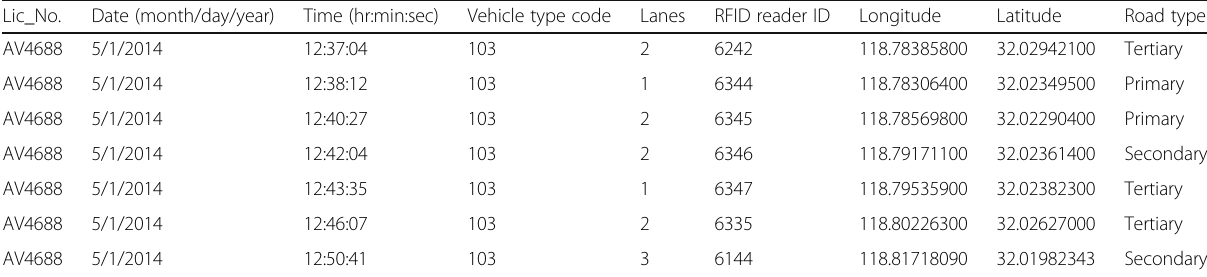
Table 4 Combined vehicle path and RFID reader ID table